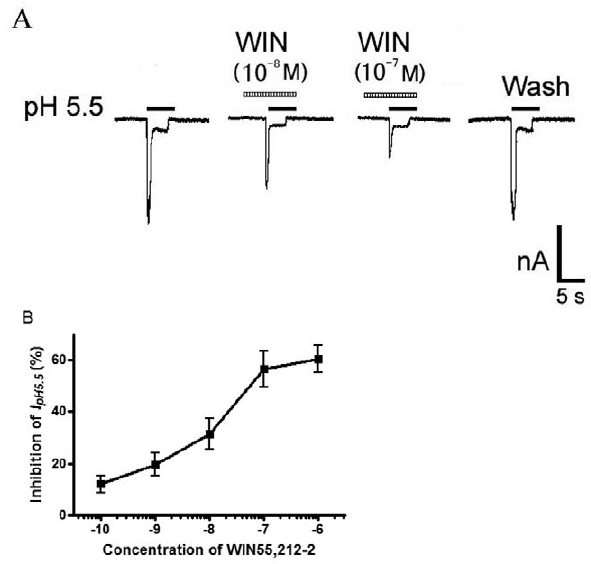
Figure 3. Concentration-dependent inhibition of proton-gated currents by WIN55,212-2. A. Sequential current traces illustrate the inhibition of proton-induced currents by different concentration of WIN55,212-2 (WIN) on a DRG neuron with membrane potential clamped at 2 60 mV. Proton-gated currents were elicited by application of pH 5.5 for 5-s durations. The pretreatment time for WIN55,212-2 was 60 s. B. WIN55,212-2 decreased proton-gated currents (I pH5.5 ) in a concentration-dependent manner (10 2 10 –10 2 6 M). Each point repre- sents the mean 6 SEM of 7–10 neurons.